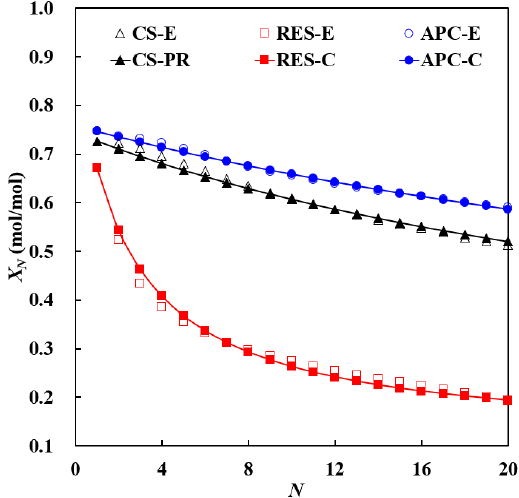
Figure 10. Characteristics of decay of carbonation reactivity.